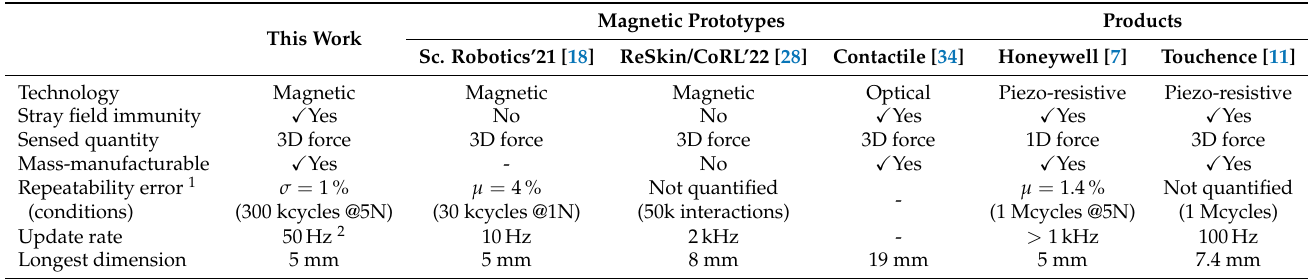
Table 1. Benchmark against other force